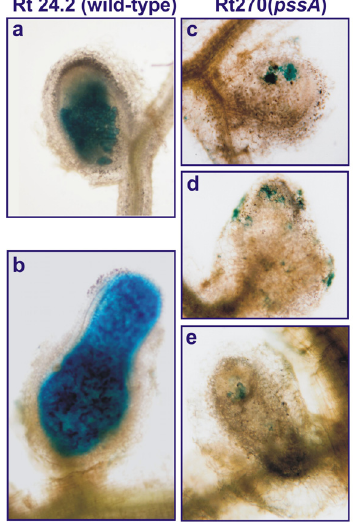
Figure 2. Light microscopy of nodules induced on roots of clover plants ( Trifolium pratense ) by the Rhizobium leguminosarum bv . trifolii wild-type strain 24.2 and the pssA mutant Rt270 harboring pJBA21Tc plasmid with gusA reporter gene for β -glucuronidase. ( a , b ) Rt24.2 wild-type nodules at 7 and 21 days post infection, respectively; ( c – e ) Rt270 nodules at 7 ( c ) and ( d ), and 21 days post infection ( e ). The nodules were stained for GUS